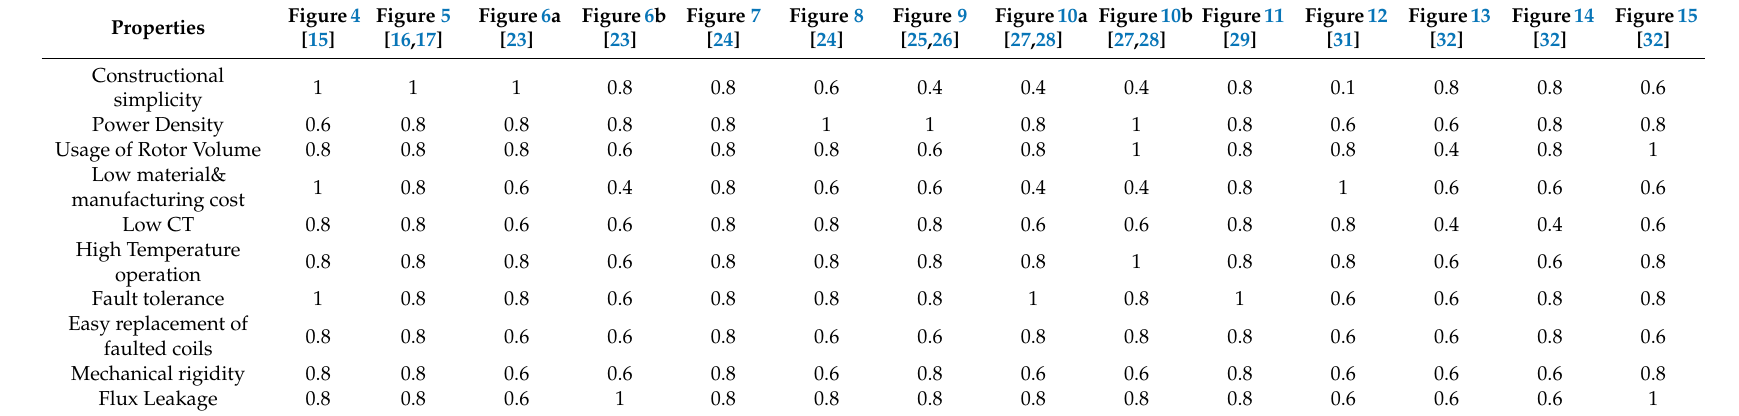
Table 4. Comparisons of various topology rare-earth (RE)-PM FRMs for wind energy